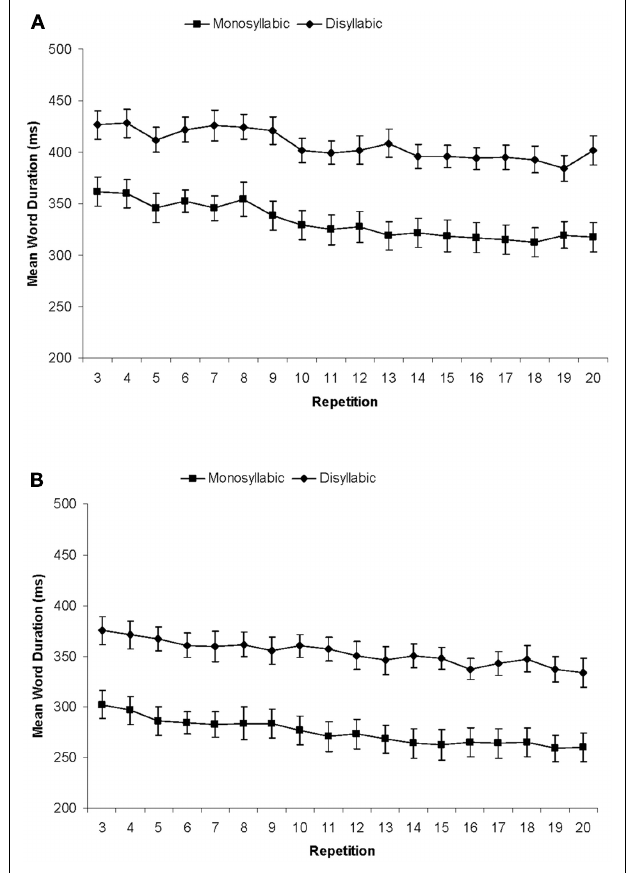
FIGURE 6 | Results of Experiment 2. Mean error rates per sequence for monosyllabic and disyllabic items on repetitions 3 through 20 of the materials in the Moderate Pace Group (A) and the Fast Pace Group (B) .